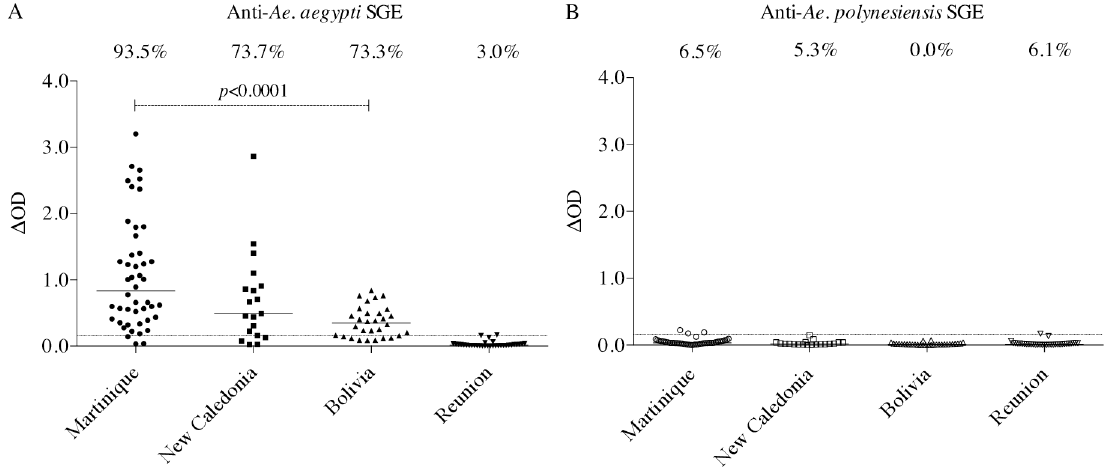
Fig 3. Antibody responses to Ae . aegypti and Ae . polynesiensis SGE from cohorts from different contexts of exposure. The figure presents the individual IgG responses ( Δ OD)against Ae . aegypti (A) and Ae . polynesiensis (B) SGE of residents from Martinique (n = 46), New-Caledonia (n = 19), Bolivia (n = 30) and Reunion (n = 33). The horizontal bars indicate the median value in each group and the dotted lines correspond to the positivity thresholds calculated from the cohort of metropolitan French residents. The percentage of responders in each cohort is shown above the plot. Residents from Martinique, New Caledonia and Bolivia, are typically exposed to Ae . aegypti bites. In Reunion island, Ae . albopictus is the main Aedes species while Ae . aegypti is cryptic. Ae . polynesiensis is not present in these islands or countries.